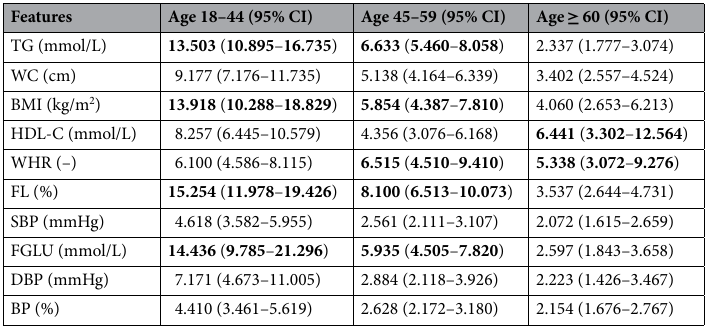
Table 4. The OR of feature’s abnormality to MetS by age groups in female. The result with the best performance in each metric using different classifiers are marked in bold characters.